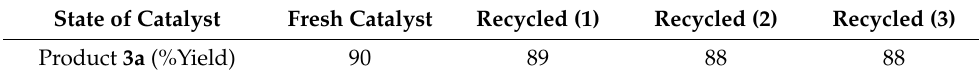
Figure 6. Optimization of the chitosan graft copolymer as basic catalyst. Table 1. Recyclability of the chitosan graft copolymer as basic catalyst.